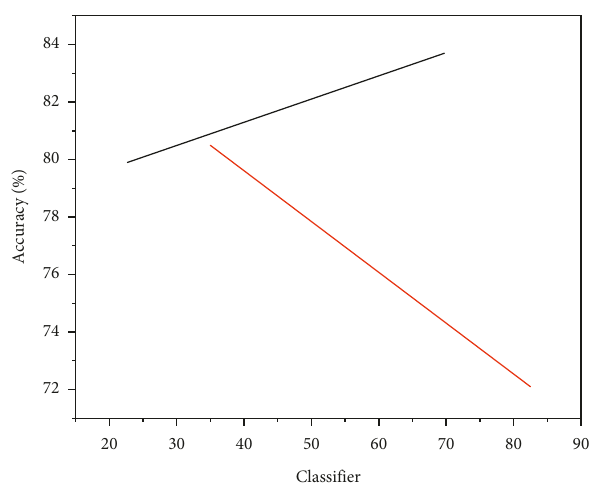
Figure 3: Accuracy of historical route